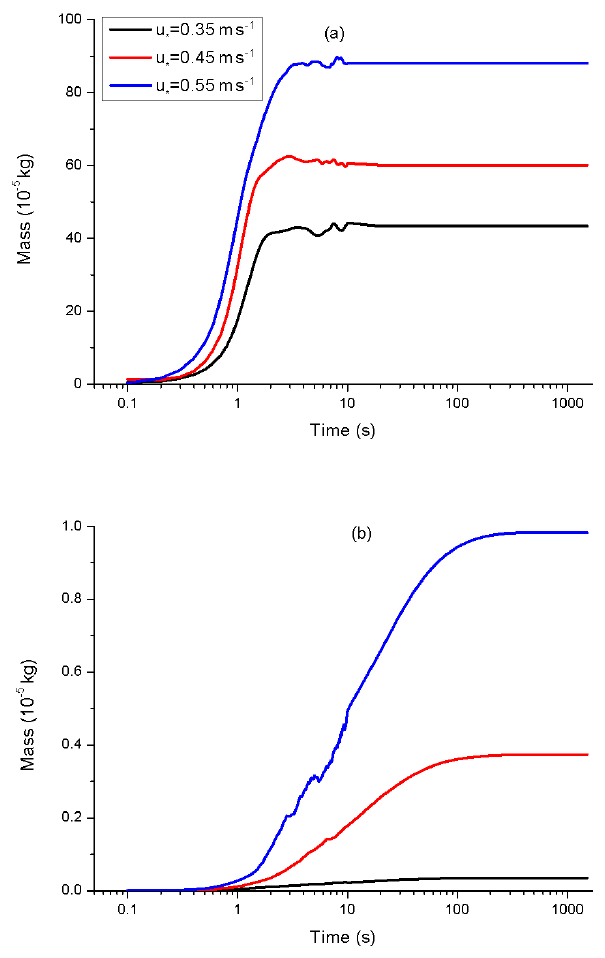
Figure 5. Temporal evolution of mass of (a) saltating particles and (b) suspended particles.